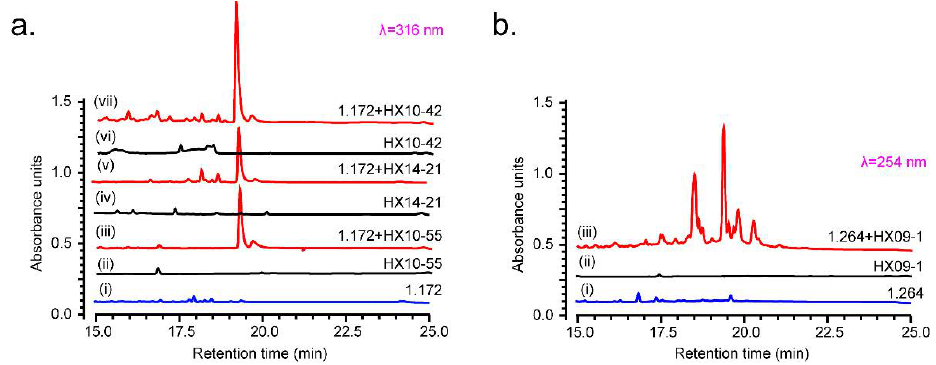
Figure 1. Preliminary evaluation of the activation ability of mycolic acid-containing bacteria (MACB). ( a ) HPLC analysis of the fermentation extracts of S . sp. FXJ1.172 co-cultured with different MACB and the extracts of their pure cultures; ( b ) HPLC analysis of the fermentation extracts of S . sp. FXJ1.264, M . sp. HX09-1, and their combined culture.